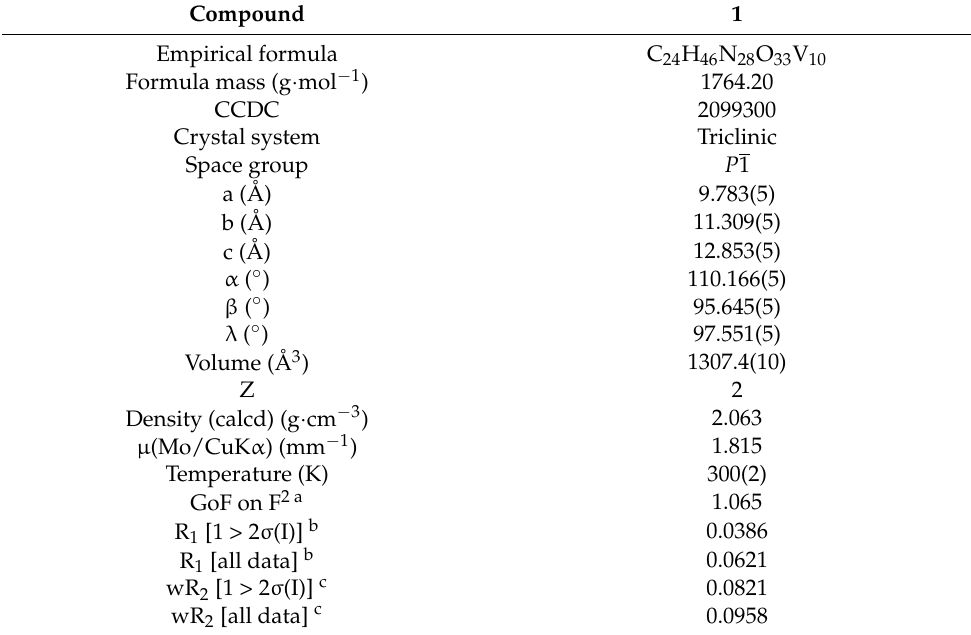
Table 1. Crystal data and structure refinement for Compound 1